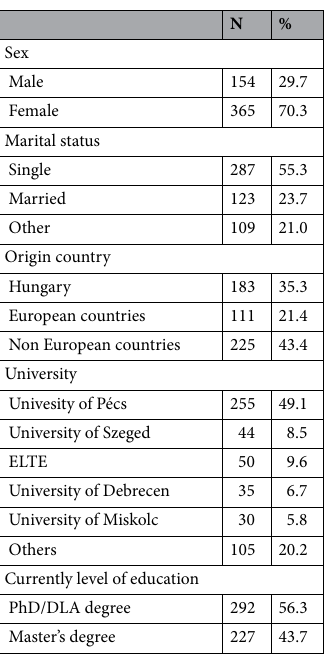
Table 1. Sociodemographic characteristics of 519 evaluated graduate students.